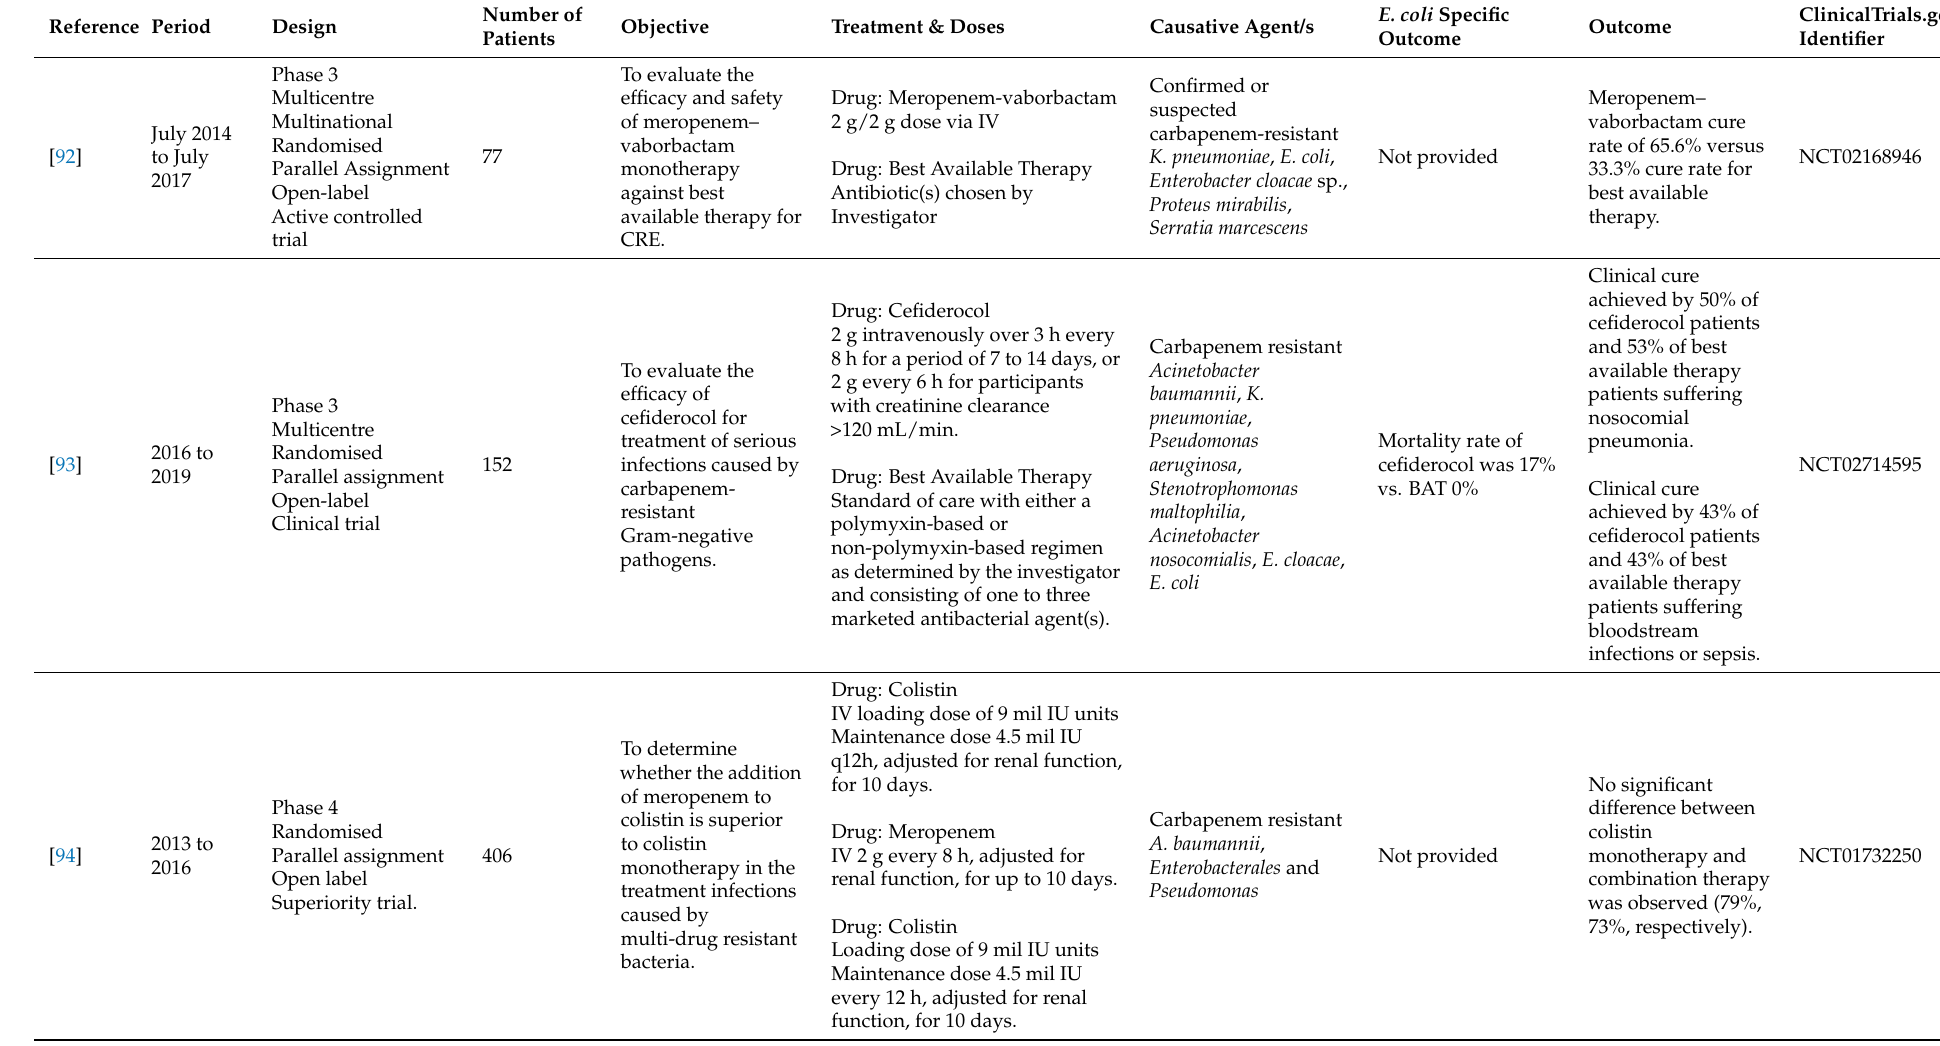
Table 1. Clinical studies evaluating the efficacy of antibiotics against numerous carbapenemase producing bacteria including E. coli